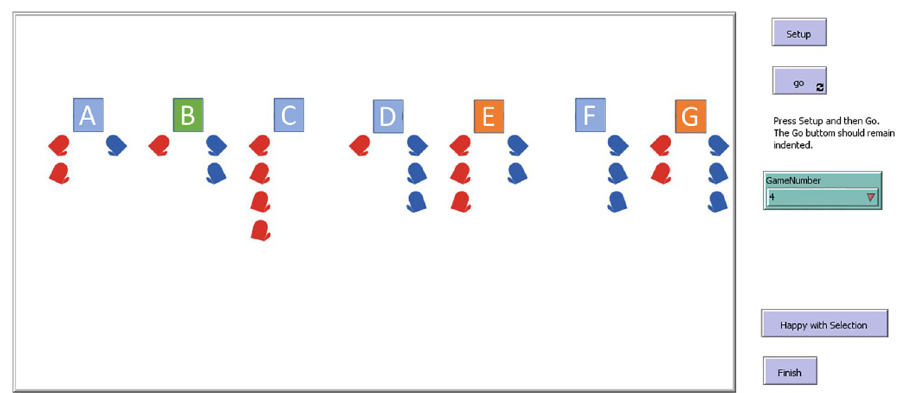
Fig 2. Graphical User Interface (GUI) used in the simulation. The agents are represented by alphabetic squares, while the human player is always player ‘A’. The colors of the squares represent the current coalition of the agents. For instance, players ‘E’ and ‘G’ are in the same coalition, and the payoff for each of them is 2.5. The left-hand gloves are shown in red and the right-hand gloves in blue. For instance, player ‘A’ above, has two left-hand gloves and one right- hand